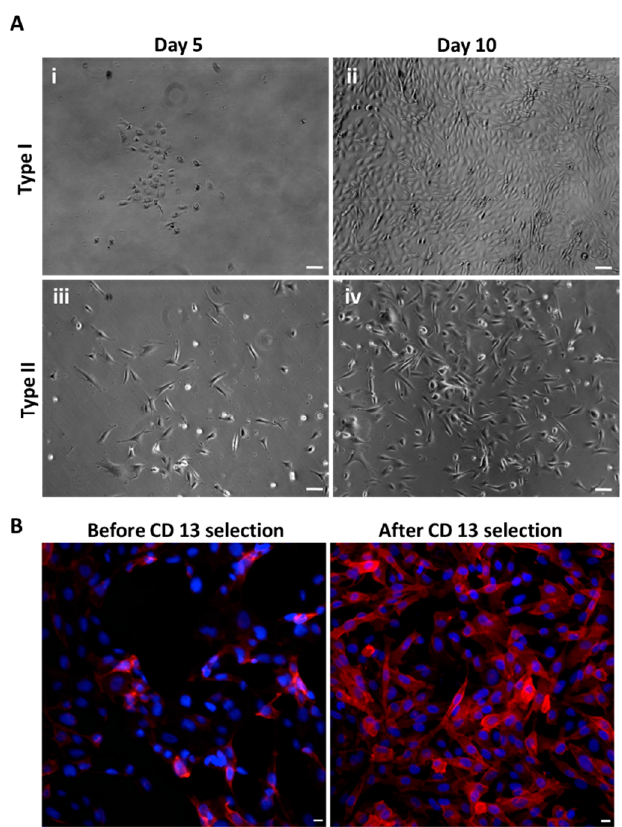
Figure 1. Urine cell culture. ( A ) Representative images of cell colonies from urinary cultures. There are two distinct types of cell colonies. i and ii: Type I cell colony is commonly found in all the cultures. The round and relatively small cells grow fast with a smooth edge. Within the colony, the cells are compact. iii and iv: Type II cell colony is less common than type I, but as often found in urine cell culture. The cells were long with slower growth characteristics than type I cells. They formed a loose colony. (Scale bar = 50 µm.) ( B ). Representative images of cells sorted by CD13 in red, a PTC marker. Nuclei were stained blue. (Scale bar = 10 µm.)